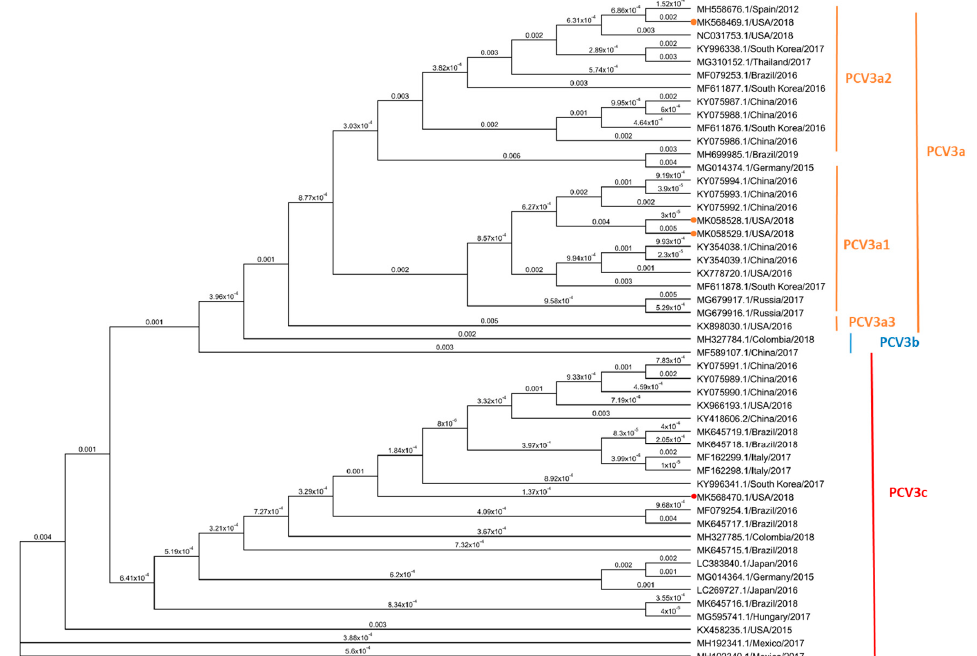
Figure 5. Phylogenetic analysis based on four full-length Cap (ORF2) protein sequences of three PCV3 isolates and 46 reference strains. Solid circles indicate the sequences of four viruses isolated in this study. Maximum parsimony (MP) tree based on the nucleotide sequences of the cap protein reconstructed using Geneious R9 software. The value along the branches represent substitutions per site. The clade of trees was estimated with 1000 replicates of bootstrap (BT) analysis. All PCV3 strains were divided into three clades, PCV3a (orange), PCV3b (blue) and PCV3c (red), based on two amino acids mutation (A24V and R27K) and phylogenetic relationship of cap gene. PCV3a was further divided into three subclades.